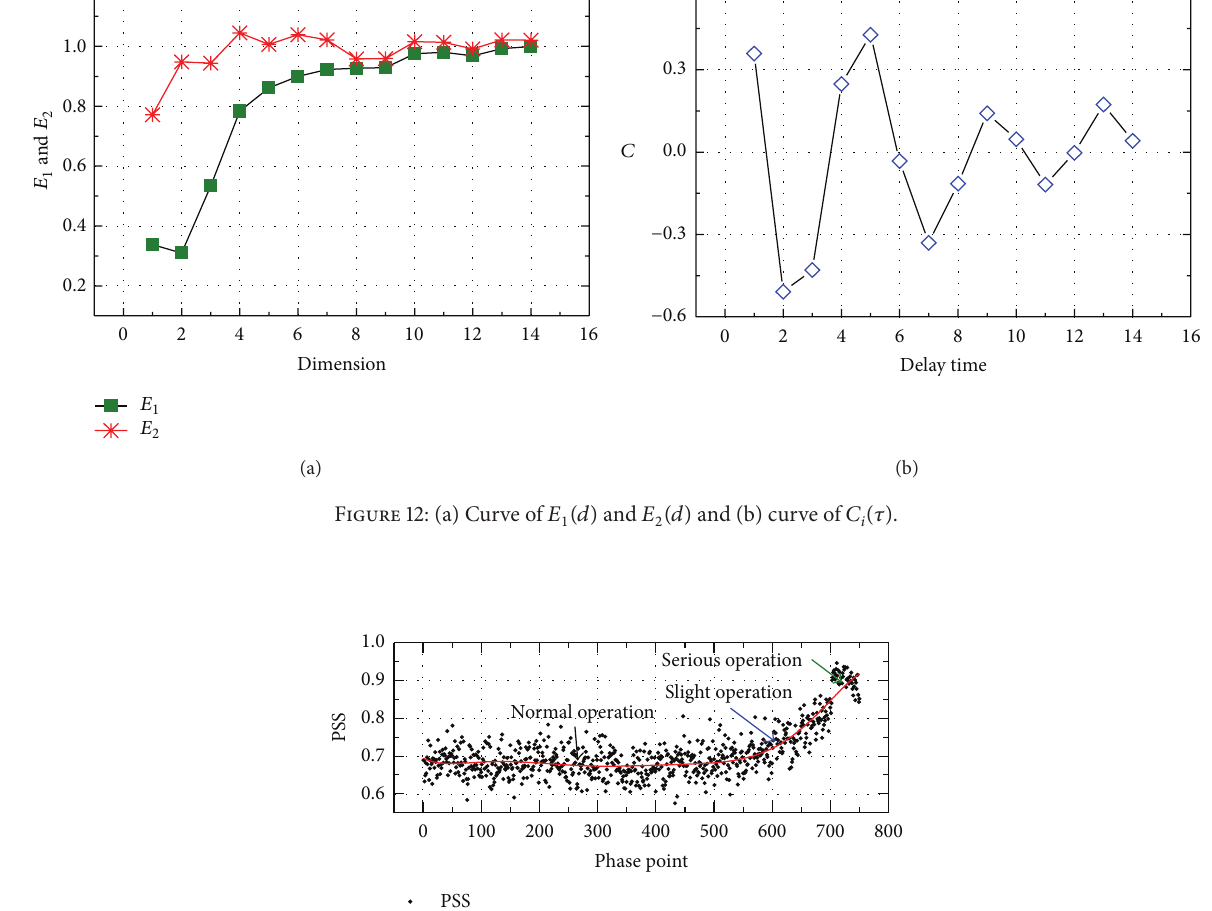
Figure 13: Bearing performance assessment based on